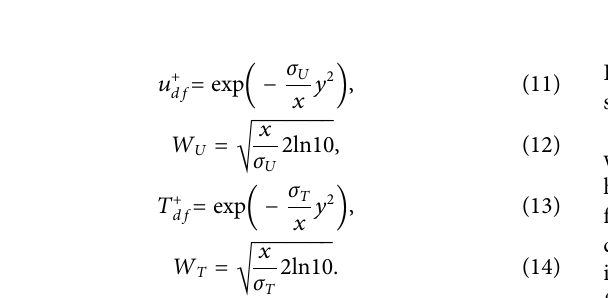
FIGURE 10 | Variations of velocity defect width, temperature defect width, velocity defect, and temperature defect in wake. The curves and formulas are fi tting results according to the data at locations of x / D ≥ 21 and R 2 represents the coef fi cient of determination. (A) Defect width; (B) velocity defect and temperature